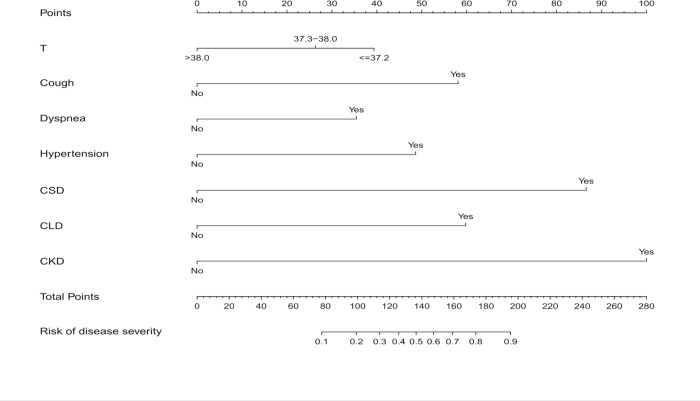
Development of a nomogram for predicting severe COVID-19.The nomogram included body temperature at admission, oxygen saturation, cough, dyspnea, hypertension, cardiovascular disease, chronic liver disease, and chronic kidney disease. The nomogram summed the scores for each scale and variable. The total score on each scale indicated the risk of severe COVID-19.